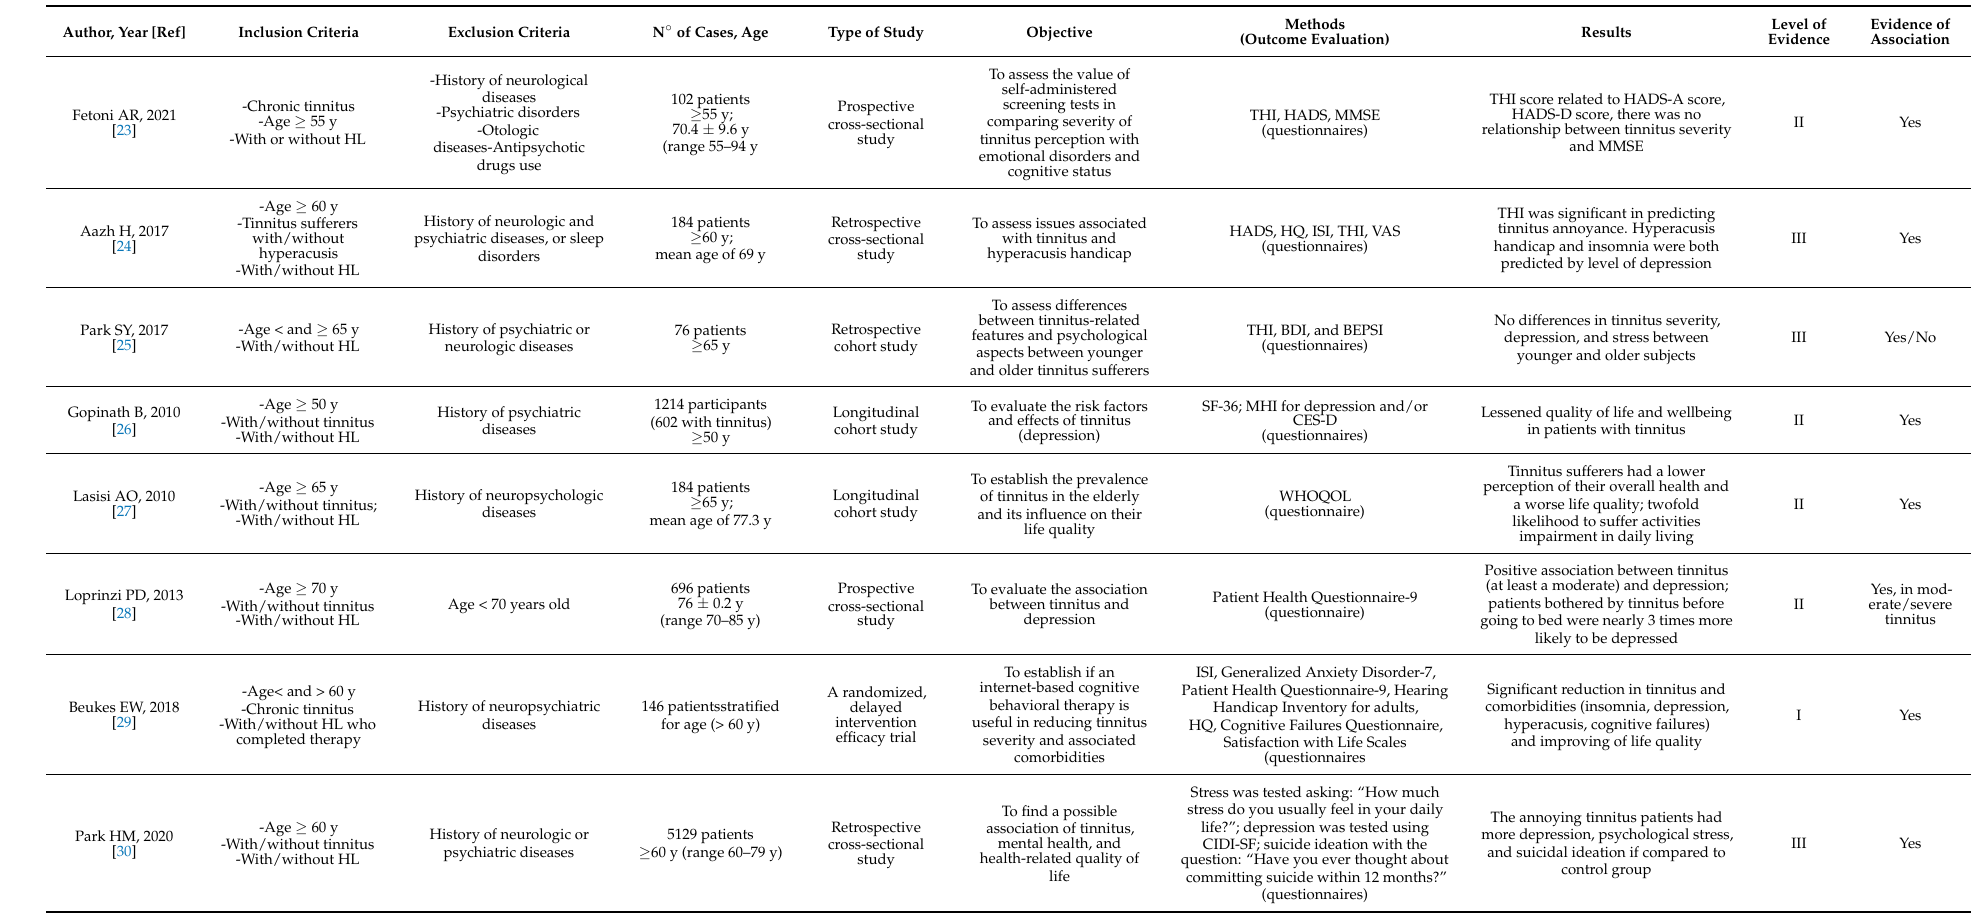
Table 1. Evidence linking chronic tinnitus to psychological disorders in the